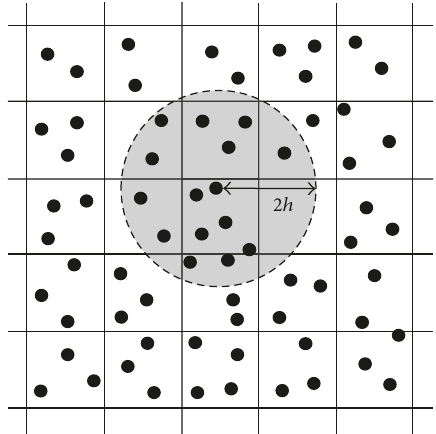
Figure 3: Interaction between SPH particles (Swaddiwudhipong et al.